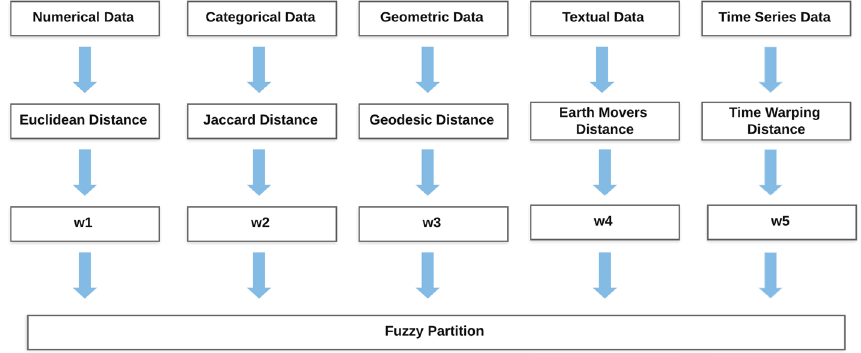
Fig. 1 FCMD-MD algorithm approach